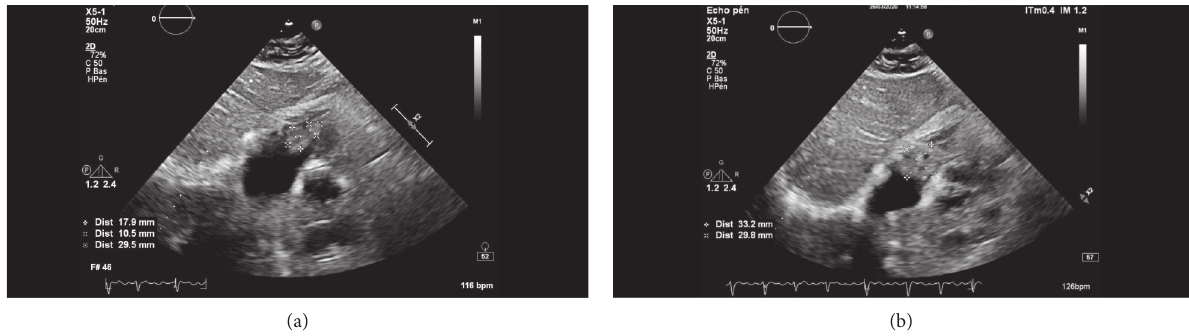
Figure 1: TTE, subcostal view, showing a right atrial thrombus in a COVID-19 suspected patient (deceased after discharge). The thrombus was prolapsing in the right ventricle in diastole.